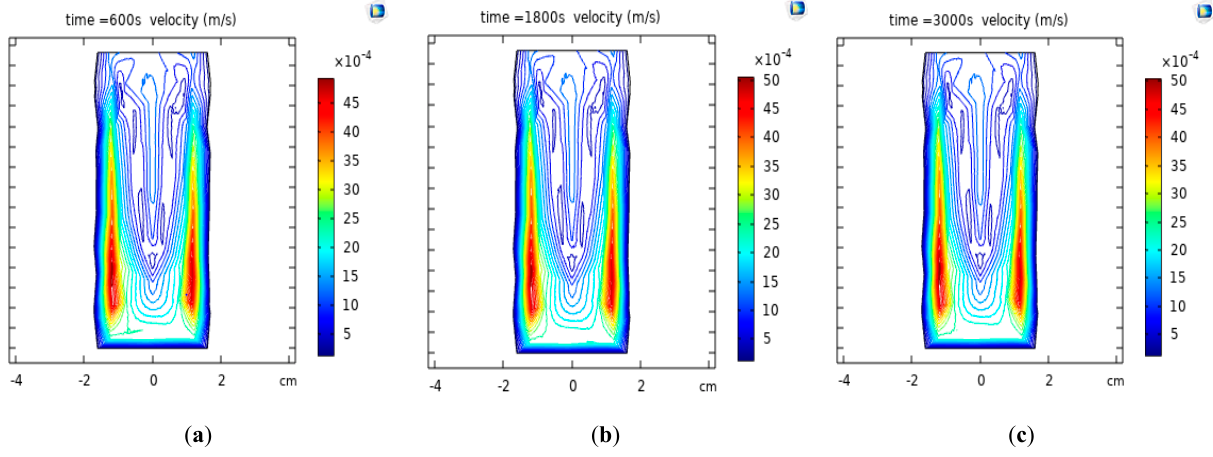
Figure 7. Velocity fields inside the reactor at three different times: ( a ) 600 s, ( b ) 1800 s and ( c ) 3000 s.